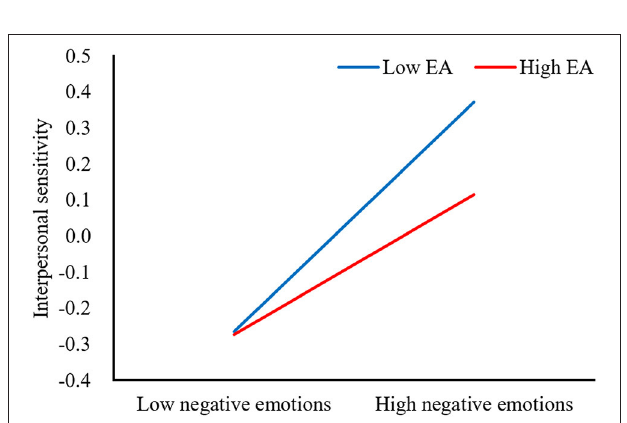
FIGURE 3 | Effects of negative emotions and EA on interpersonal